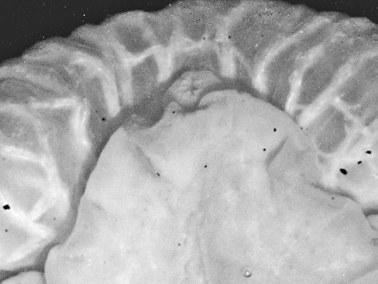
Doriopsilla nigrocerasp. n., holotype, ventral view of propodium, head, and oral tentacles.